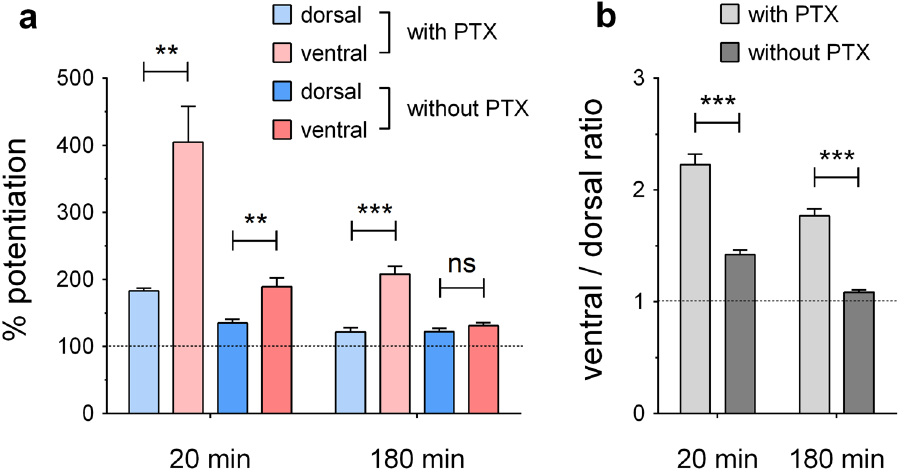
Figure 3. Picrotoxin (PTX) has a stronger potentiating effect on the ventral dentate gyrus in young mice (2–3 months old). ( a ) Levels of potentiation obtained at 20 and 180 min after the start of HFS, for dorsal and ventral slices, with or without the addition of PTX to the recording solution during induction (as can be derived from Figs 1c and 2c, respectively). ( b ) Comparison of mean ventral/dorsal ratios, calculated based on all possible ratios, for both conditions at 20 and 180 min. Unpaired t tests with Welch’s correction were used for statistical comparisons ( ** indicates p < 0.01 and *** indicates p < 0.001).